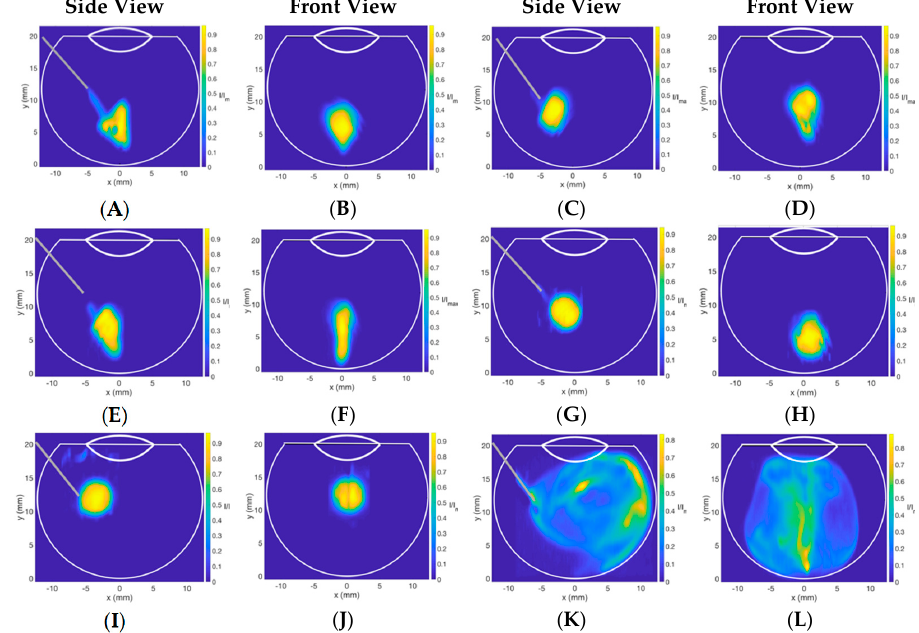
Figure 8. Contour plot of the dye concentration injected in different vitreous substitutes at low Re (189 ± 91), slow injection times (>1 s). ( A , B ) 1.0 mg/mL HA, ( C , D ) 2.0 mg/mL HA, ( E , F ) 3.0 mg/mL HA, ( G , H ) S500, ( I , J ) S1000, and ( K , L ) BSS. At slow injection rates, the injected bolus remained localized in all vitreous substitutes, thereby minimizing the stretching and spread of IVT.